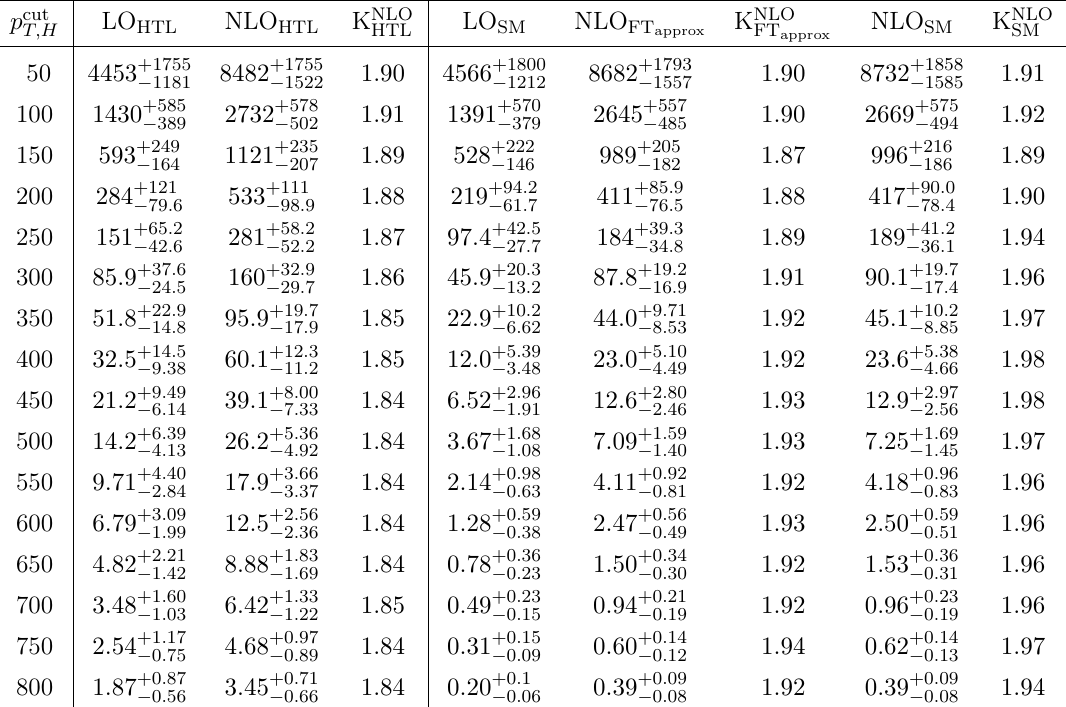
Table 3 . Integrated cross sections in fb depending on p cut and with full top-quark mass dependence (SM) for H+ jet production at the LHC with together with corresponding K-factors. Uncertainties correspond to the envelope of 7-point scale variations. We require p T ; j > 30 GeV